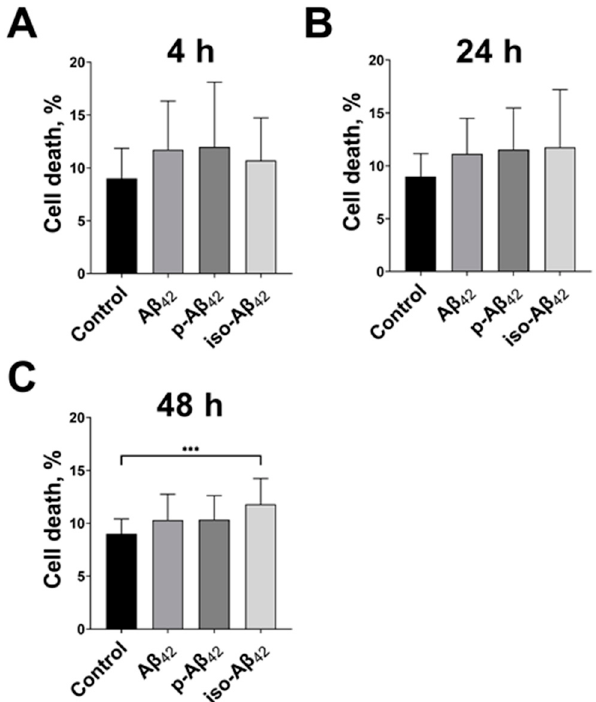
Figure 1. The effects of beta-amyloid isoforms on bEnd.3 cell death. The cells were incubated for ( A ) 4 h, ( B ) 24 h and ( C ) 48 h with 10 µ M of A β 42 , p-A β 42 and iso-A β 42 . The percentage of propidium iodide positive (dead) cells was analyzed by flow cytometry. The mean ± SD in 7 independent experiments in triplicates is shown in the figure. The statistical difference between experimental groups was analyzed by one-way analysis of variance using the post hoc Tukey test for multiple comparisons. ***— p < 0.001.